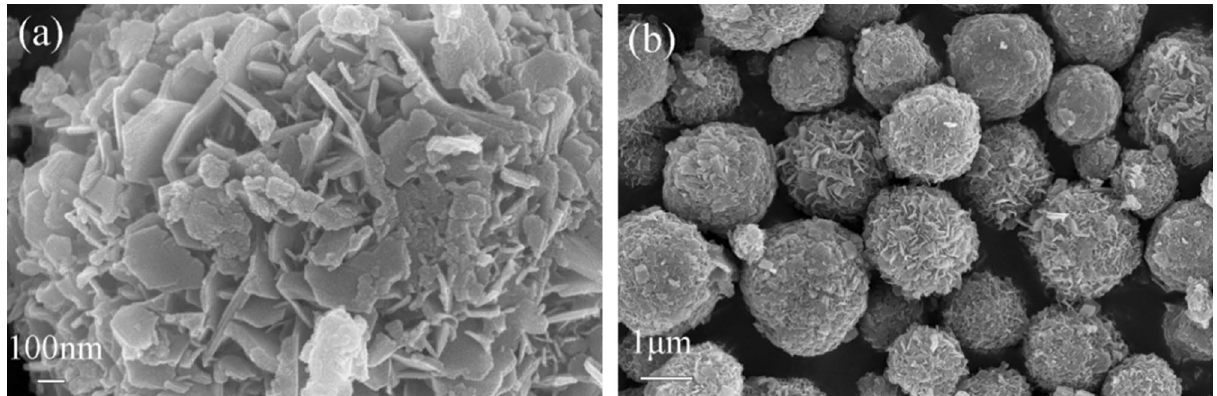
Figure 11. SEM images of ZnNiAl-LDHs before ( a ) and after ( b ) U(VI) adsorption.